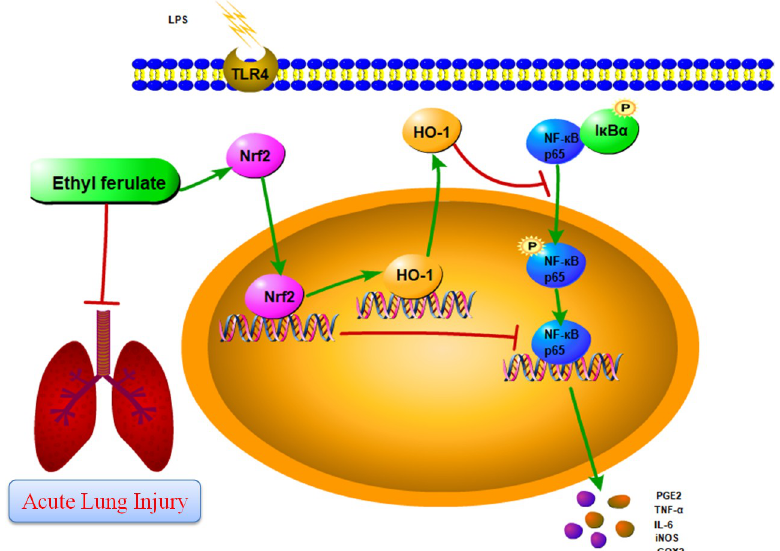
Fig 10. Schematic diagram of the mechanism. We systematically analyzed the mechanism of EF effect on LPS signaling, and found EF profoundly activated Nrf2/HO-1 signal transduction pathways and inhibited NF- к B signal pathways, known to be involved in the regulation of inflammatory responses, by